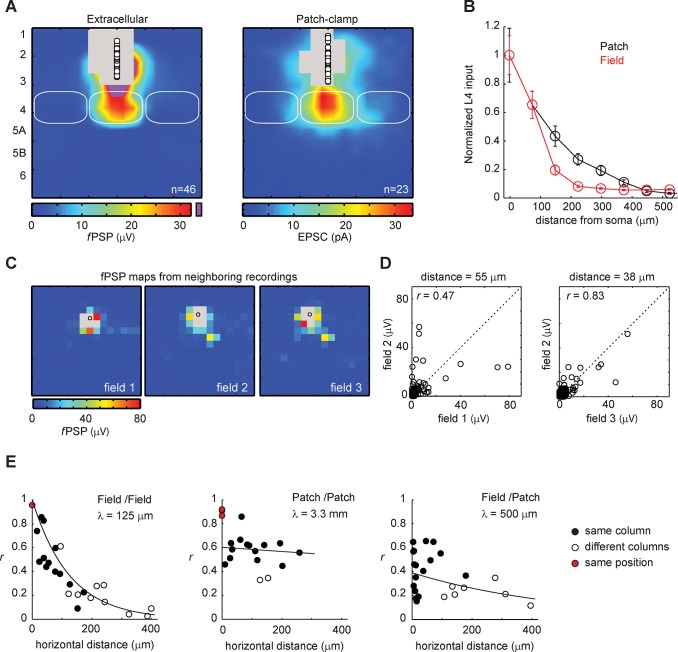
Comparison of the fPSP maps with maps computed from excitatory postsynaptic currents recorded in patch-clamp.
A, The group-average fPSP map (left) and EPSC map (right) computed from recordings in layer 2/3 show similar patterns of inputs. The region in purple is where fPSP peak amplitudes were greater than the upper limit of the color scale. Numbers on the side indicate the layers. The regions in grey are where directly-evoked responses prevented the measurement of synaptic responses. B, Horizontal profile of synaptic inputs evoked by stimulations in layer 4 and received by layer 2/3 for extracellular field recordings (red) and patch-clamp recordings (black).C, Three fPSP maps obtained from a single slice. D, The plots show the pixel-wise comparison for two pairs of maps shown in C. r is the correlation coefficient. The diagonal dashed line shows the perfect correlation. Some sites gave inputs in one of the maps only, yielding points that fall along the zero lines (horizontal/vertical axis). The distances indicated above the plots are the horizontal distances between recording positions. E, Correlation coefficient as a function of distance between recording positions in pairwise comparisons of fPSP maps (left) or EPSC maps (middle). The right panel shows the comparison between fPSP and EPSC maps. The black symbols are for pairs recorded in a same cortical column, the whites for pairs recorded in neighboring columns and the red for pairs recorded at the exact same position (i.e., repetitions).